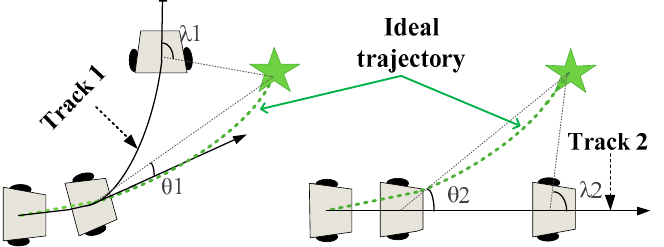
Figure 7. ℎ𝑒𝑎𝑑𝑖𝑛𝑔(𝑣,𝑤) mechanistic analysis. Figure 7. heading ( v , w ) mechanistic